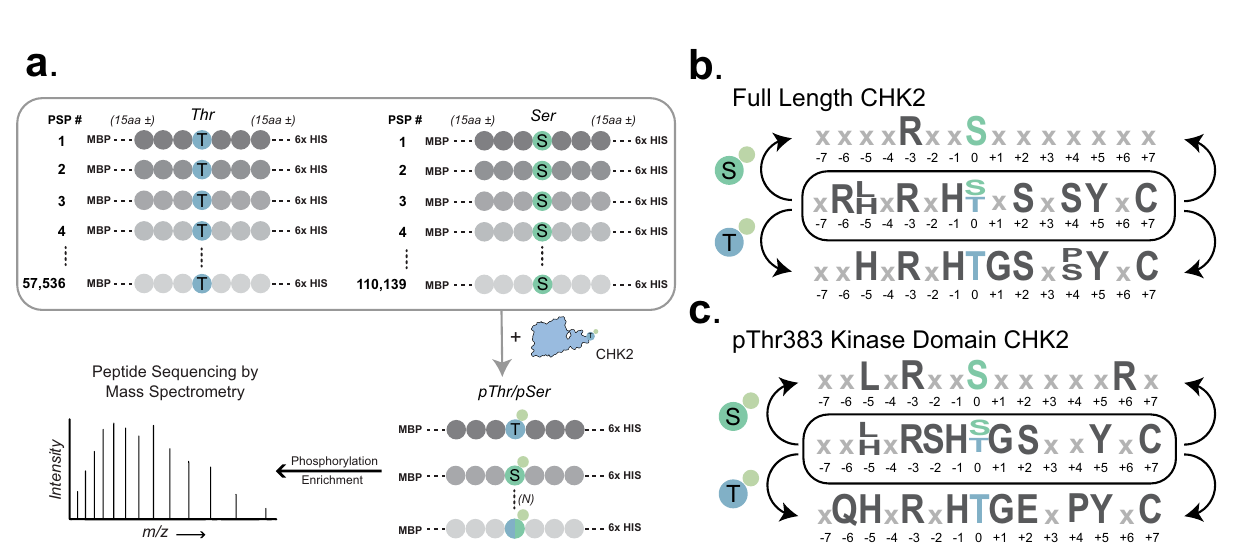
Fig.4|Kinasepro fi lingofCHK2variantsidenti fi esmotifelements.a Schematic of kinase pro fi ling with active CHK2 kinase against both Ser and Thr phosphosite libraries. pLogo motif enrichment analysis of phosphosite substrates identi fi ed by